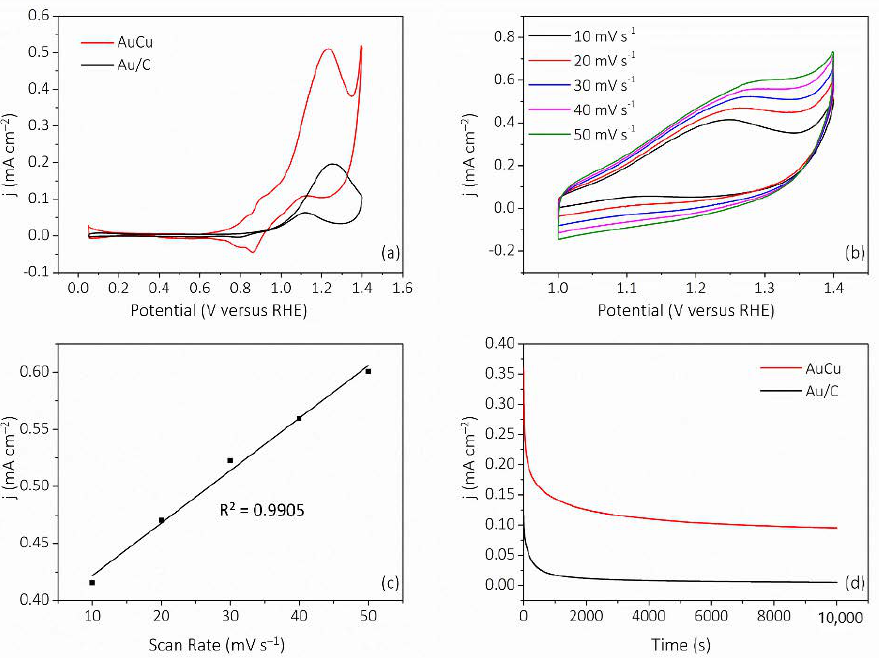
Figure 6. MOR electrocatalytic evaluation of AuCu. ( a ) CVs of AuCu and Au/C. ( b ) CVs of AuCu taken at various scan rates. ( c ) Calibration plot of the oxidation peak current density versus scan rate. ( d ) CA curves of AuCu and